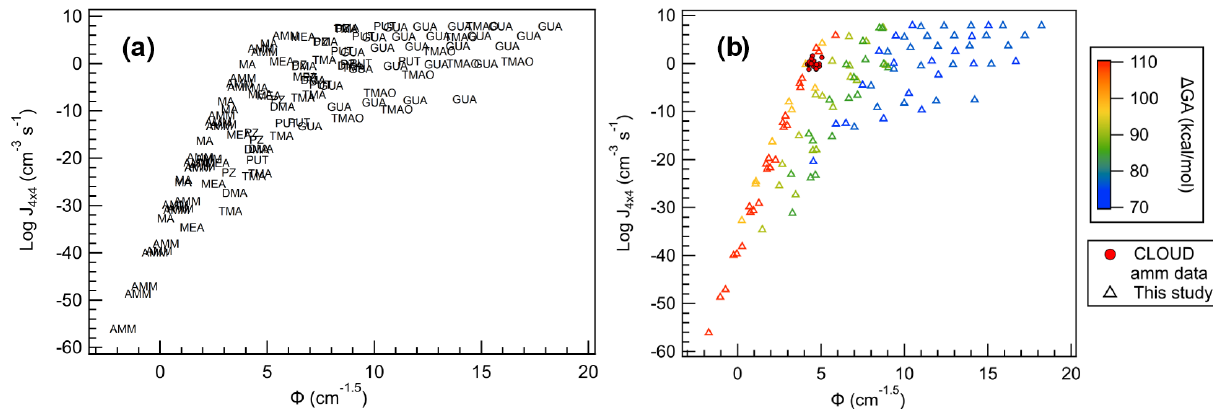
Figure 13. All SA salts plotted with (a) base names as markers and (b) markers colored according to their (cid:49) GA values. CLOUD observations are shown as filled